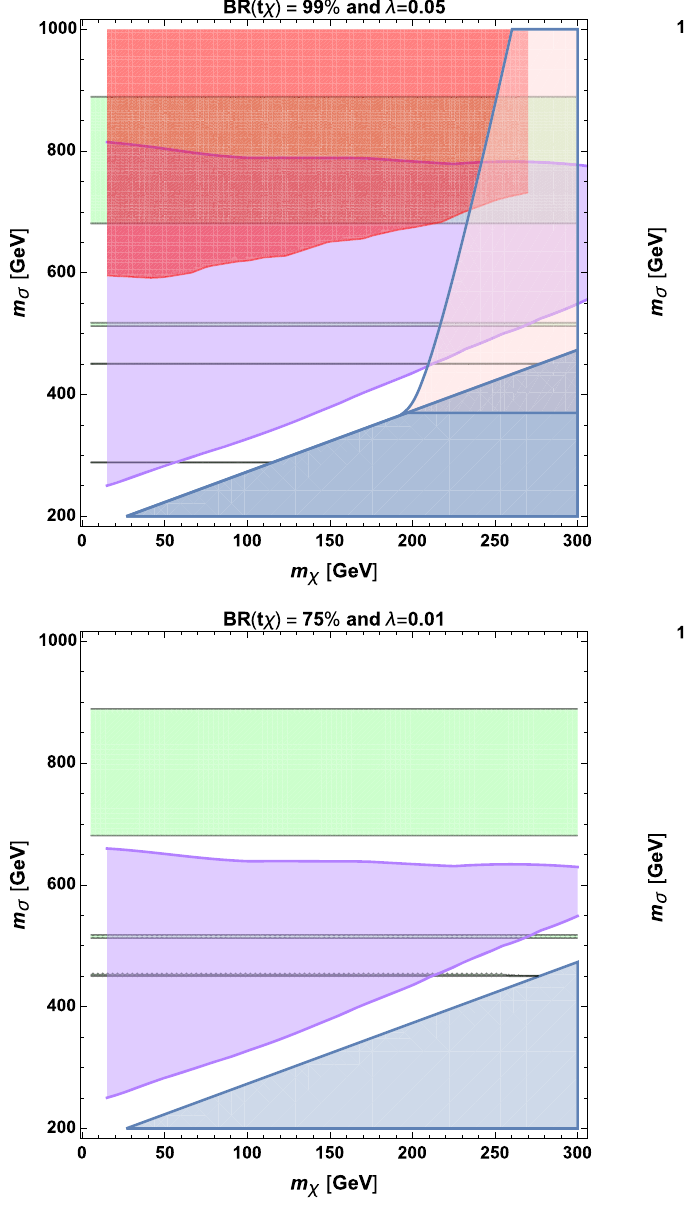
Fig. 9 Current constraints on the parameter space of the considered model featuring resonant monotop production at colliders. The results are presentedin ( m χ , m σ ) planesfor various λ and BR t χ 99% and75%. Whilst the white region are allowed, the coloured areas are excluded by at least one of the bounds described in Sect. 3. We refer to the text for more details